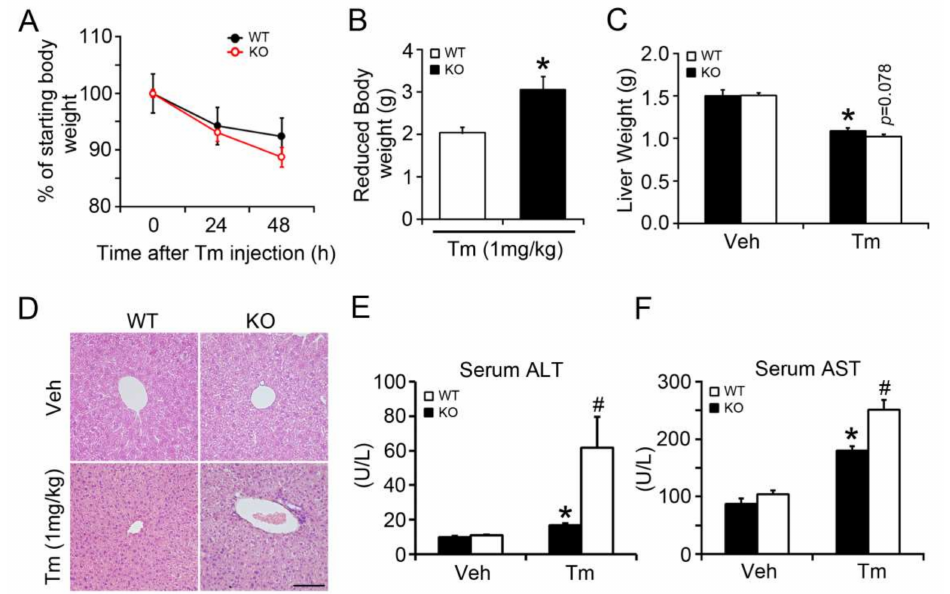
Figure 1. BAP31 deficiency promoted liver dysfunction after Tunicamycin injection. ( A ) Wild-type (WT) and liver-specific BAP31 knockout mice (KO) (16-week-old) were injected with Tunicamycin intraperitoneally. Body weight was monitored for 48 h and presented after normalization to that at 0 h after Tm injection. n = 7–8 per group. ( B ) Reduced body weight and ( C ) liver weight were monitored for each group. n = 7–8 per group. ( D ) Representative hematoxylin and eosin (H/E) staining of livers from WT and KO mice post Tunicamycin administration for 48 h (200 × , scale bar = 100 µ m). n = 4 per group. ( E ) Serum alanine transaminase (ALT) and ( F ) aspartate transaminase (AST) were determined in WT and KO mice injected with vehicle (Veh) or Tunicamycin (Tm) for 48 h. n = 7–8 per group. Data represent as mean ± SEM. *, p < 0.05, Tm compared with Veh group. #, p < 0.05, KO compared with WT mice injected with